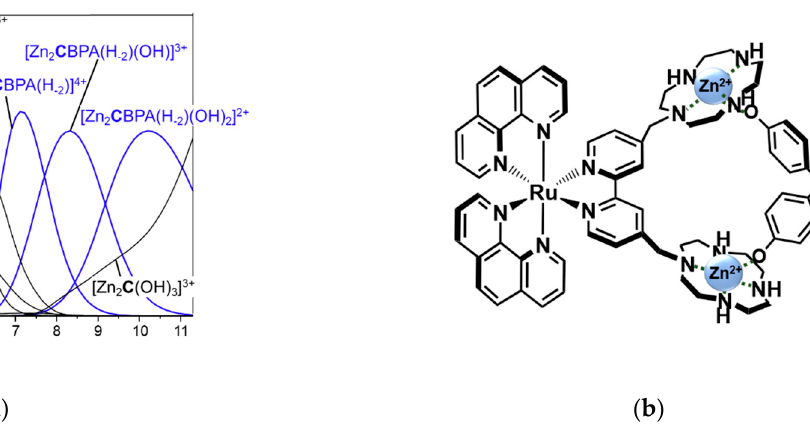
Figure 5. Normalised absorption (black dashed line), emission (black line) and excitation (red line) spectra of [Ru(phen) 2 L ] 2+ .